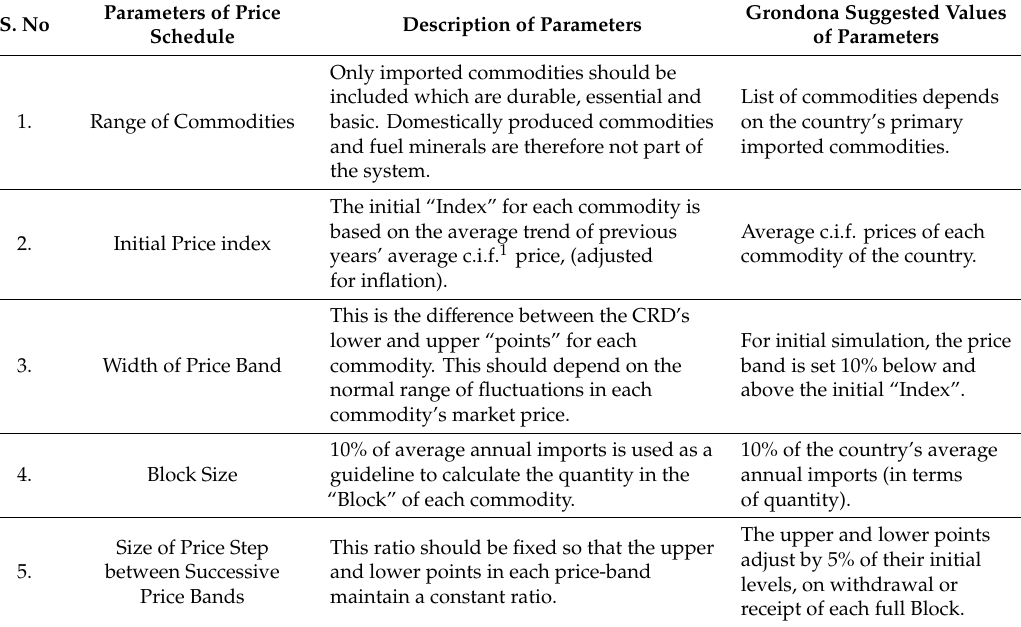
Table 4. Description of Parameters of Price